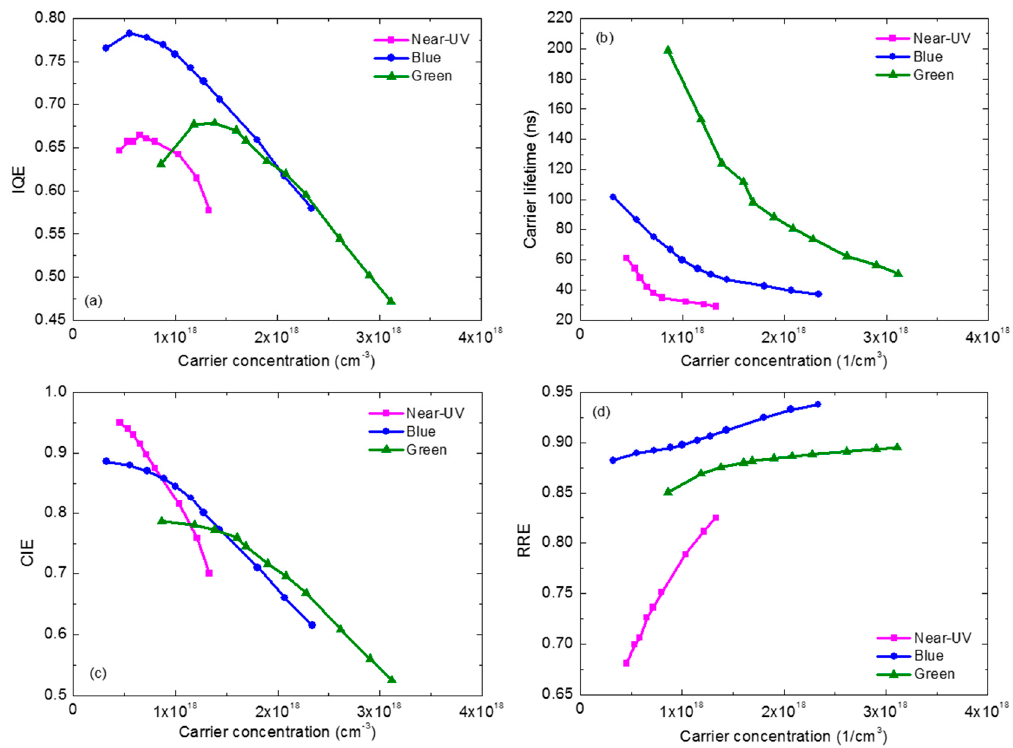
Figure 7. ( a ) IQE; ( b ) carrier lifetime; ( c ) CIE; and ( d ) RRE depending on carrier